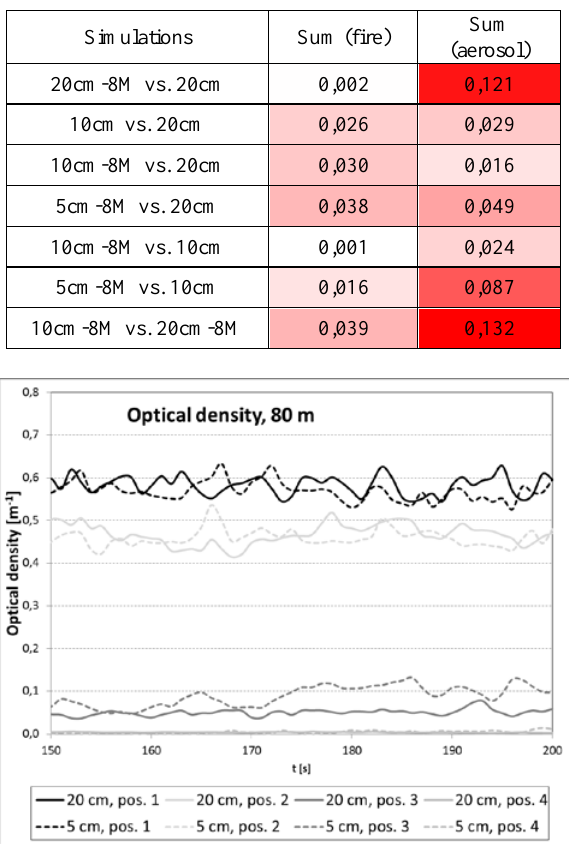
Table 1. Sum of squared differences of optical density values [m -2 ] for selected simulations couples for fire and aerosol